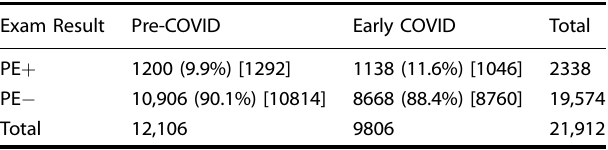
Fig. 1 Weekly CTPA exams performed. Total weekly number of CTPA exams performed at each institution ( a ) and across all of the institutions combined ( b ), demonstrating an overall decrease in the early pandemic period (red), compared to the pre-pandemic period (green). Table 2. CTPA results during the two observation